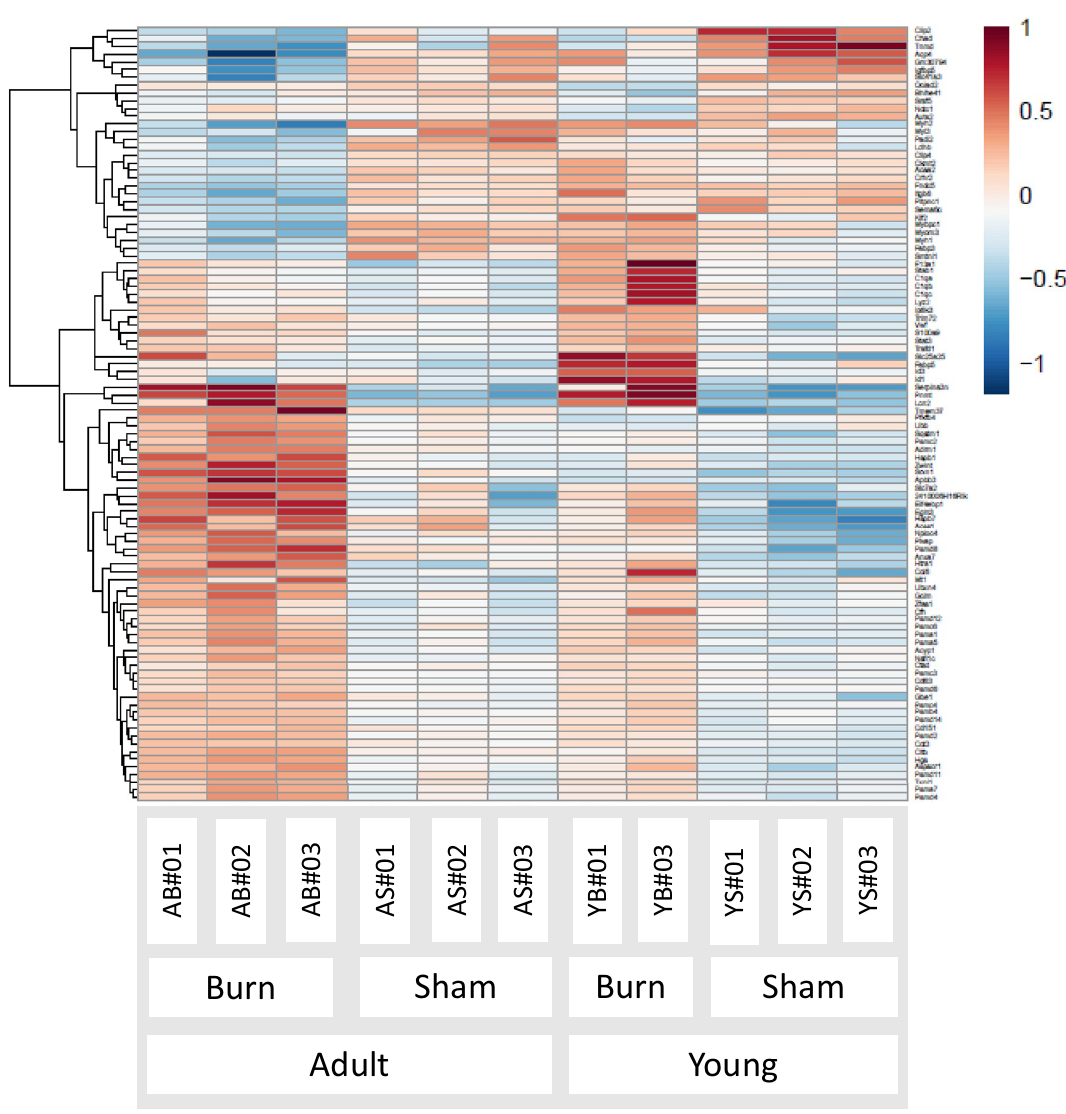
Figure 2. Using analysis of variance, the burn effect difference between young and adult was presented in the clustered heatmap. The heatmap was created with the ‘pheatmap’ R package (Pretty Heatmaps, version: 1.0.12, CRAN) showing the top 100 genes with the largest burn effect differences between the young and adult mice. Four groups were labeled as a young sham (YS), young burn (YB), adult sham (AS), and adult burn (AB). One animal presented as an outlier and thus been excluded in the young burn group. A positive log2 fold change means the change due to the adult burn is higher than the young burn with pseudo red color. The intensity of pseudo colors indicates the degree of an altered gene either upregulated with red color or downregulated with blue color. Two-way ANOVA with a post-hoc test was applied, and significance was accepted at p values <